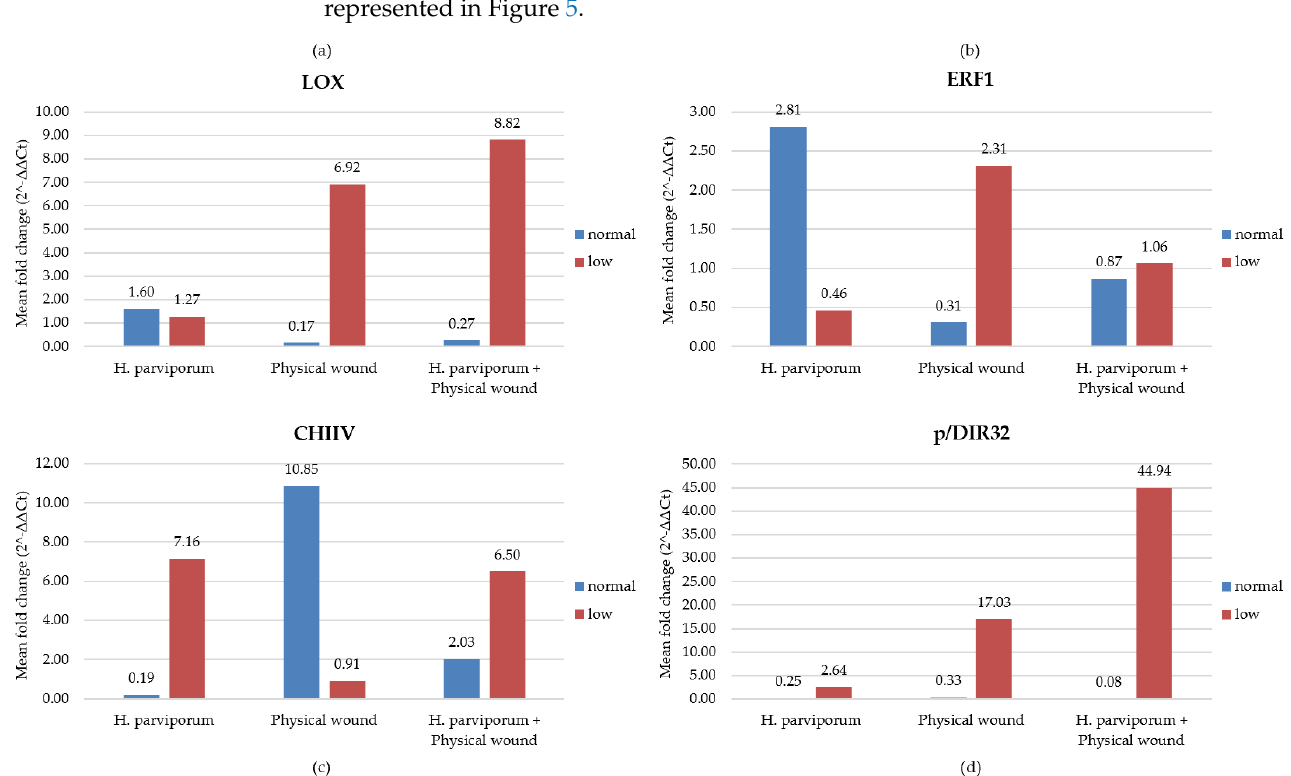
Figure 5. Influence of H. parviporum infection and physical wounding as singular and combinatorial factors in Norway spruce defense responses under drought stress conditions, as reflected by gene regulation in ( a ) LOX, ( b ) ERF1, ( c ) CHIIV, and ( d )